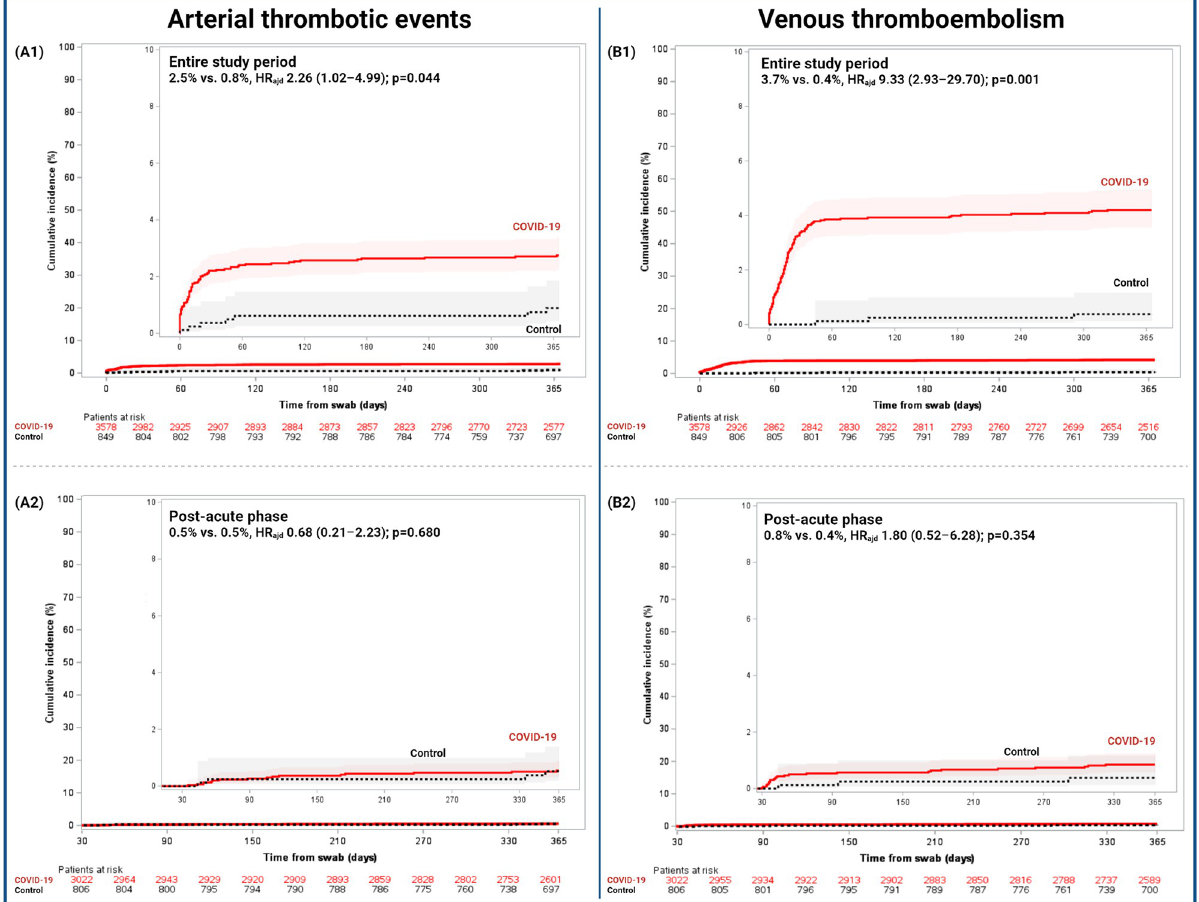
Fig 3. Cumulative incidence of arterial thrombotic events and venous thromboembolism in the COVID-19 and control cohorts. Cumulative 1-year incidences are shown with Kaplan-Meier event rates with 95% CI. (A1 and B1) Entire study comprised from 0–365 days and (A2 and B2) post- acute phase from 31–365 days. Adj HR, adjusted hazard ratio; 95%CI, 95% confidence